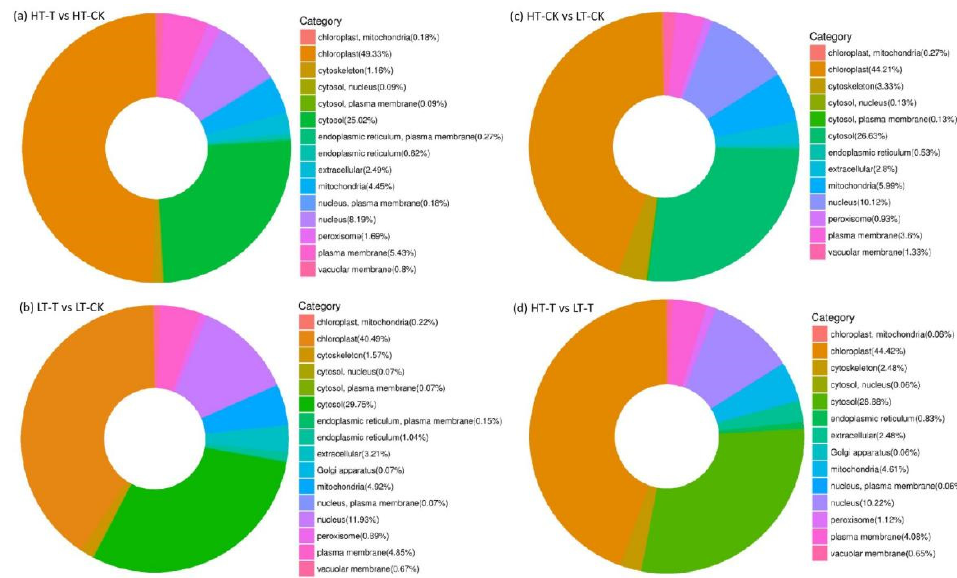
Figure 3. The subcellular localization of differentially abundant proteins from all comparison groups.